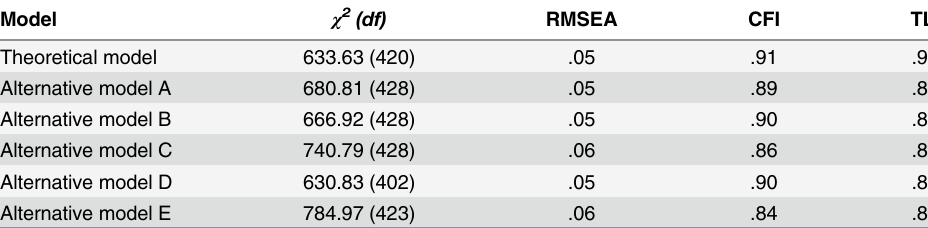
Table 2. Results from confirmatory factor analyses in study